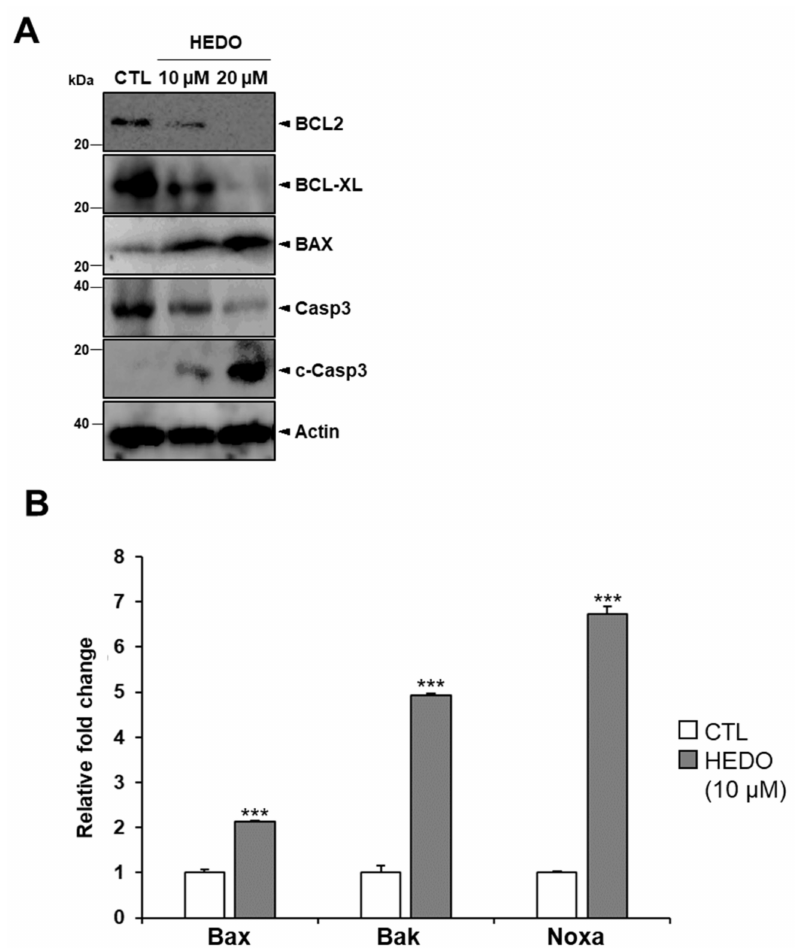
Figure6. HEDO-inducedapoptosis markersinOCI-LY3 cells. ( A )Whole